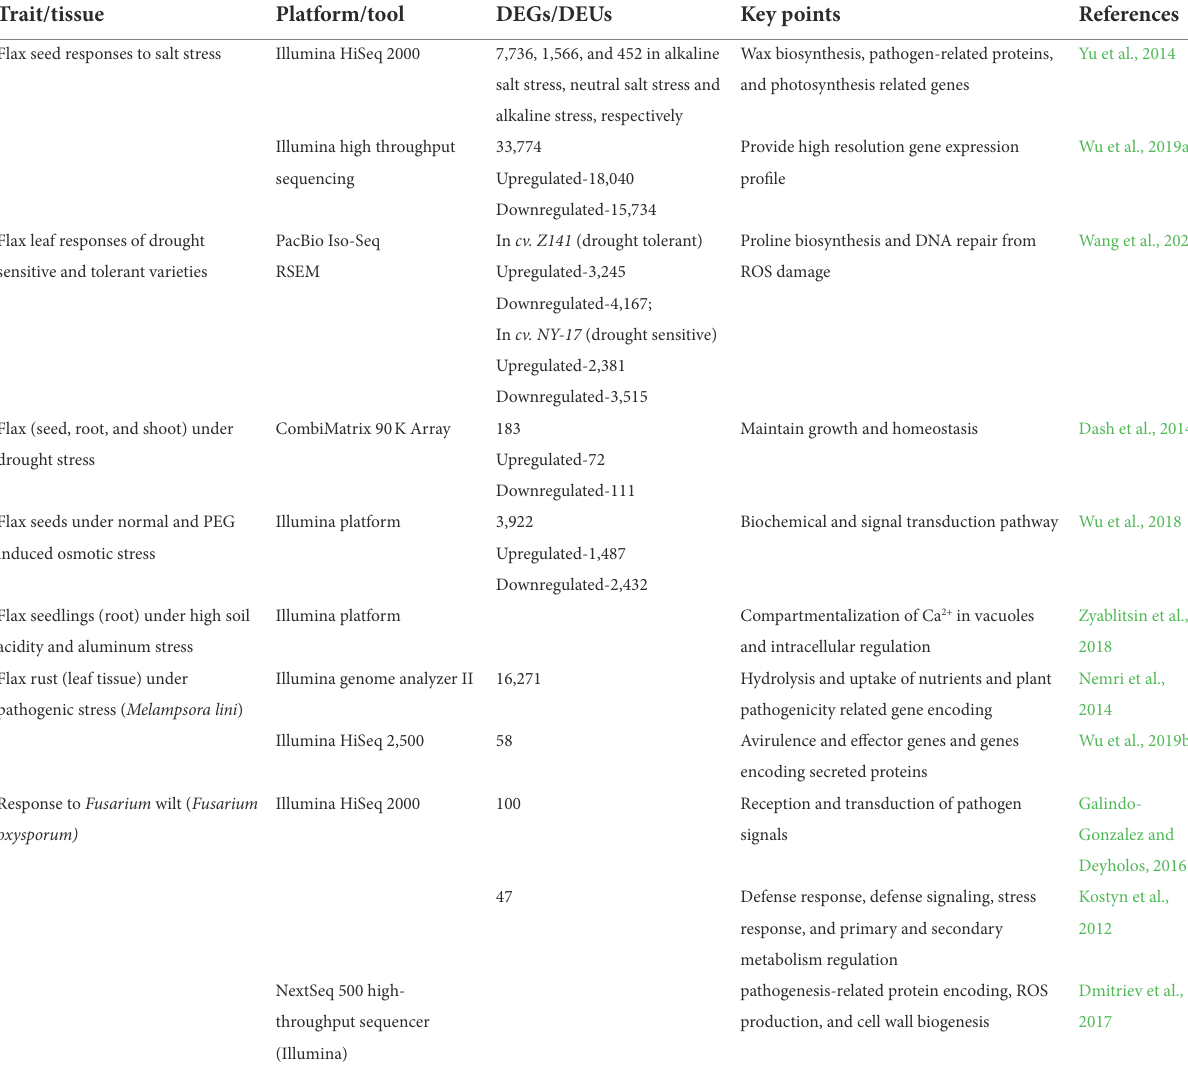
TABLE 2 Global transcriptomic analysis revealing gene expression profiles in response to major abiotic and biotic stresses in